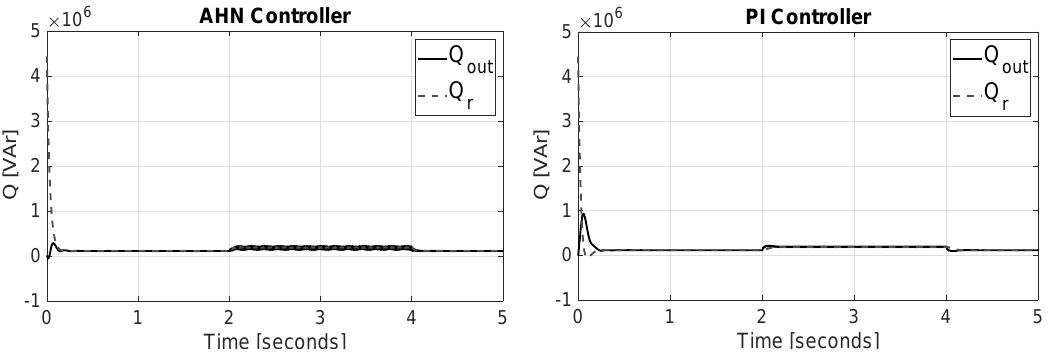
Figure 15. Simulation of reactive power regulation in Test